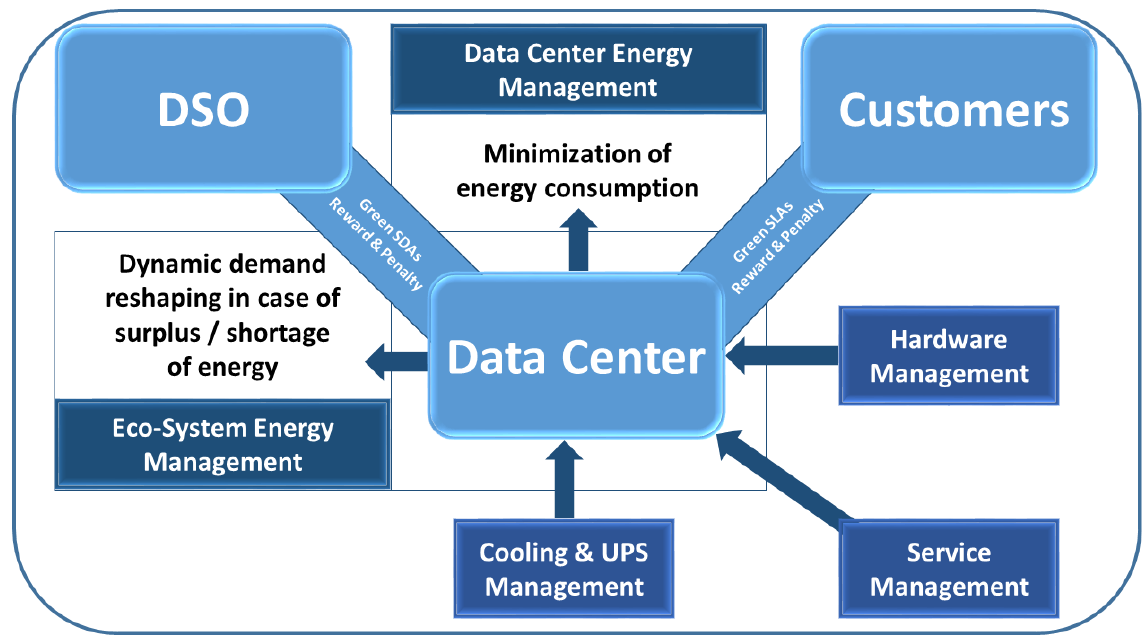
Figure 2. An EMS for leveraging peak power demand